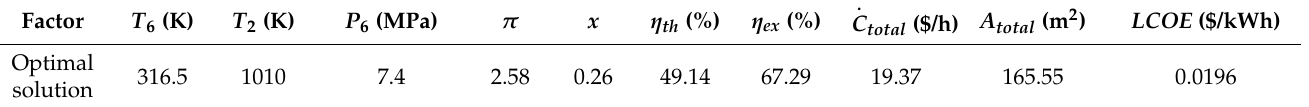
Table 10. Final results of the key optimization parameters.